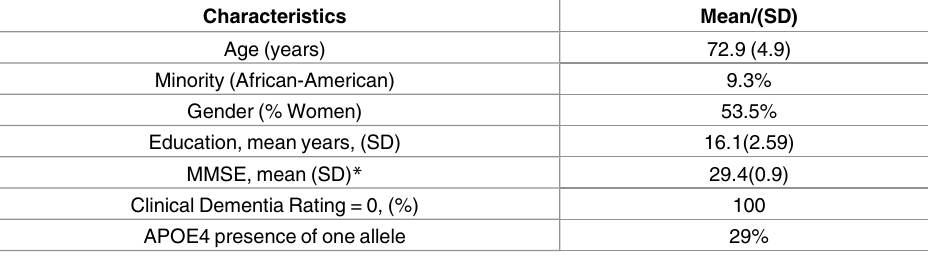
Table 1. Demographics (N =